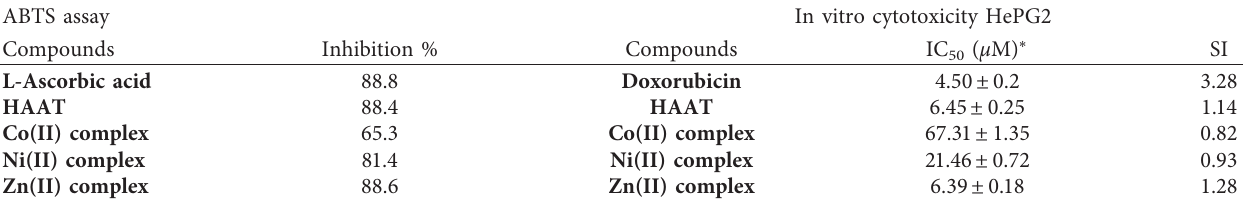
Table 7: ABTS antioxidant assay and in vitro cytotoxicity against HepG2 cell line of the ligand and its complexes. ABTS assay